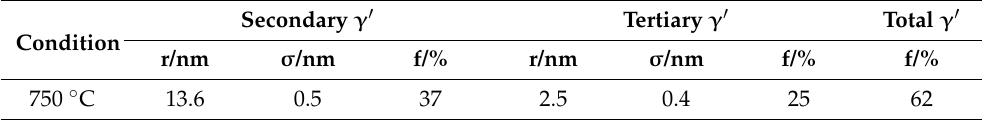
Figure 7. ( a ) SANS scattering curves of CoWAlloy1 at 1075 ◦ C and after cooling down to 750 ◦ C. The measurement after 750 ◦ C consists of the log-normal distributed secondary and tertiary γ (cid:48) precipitate contributions. ( b ) The obtained log-normal size distributions of the precipitates at 750 ◦ C. Table 2. Mean radius r and volume fraction f of secondary and tertiary γ (cid:48) precipitates after cooling to 750 ◦ C as determined by using small-angle neutron scattering (SANS). The width parameter σ represents the broadness of the γ (cid:48) log-norm size distributions and the standard